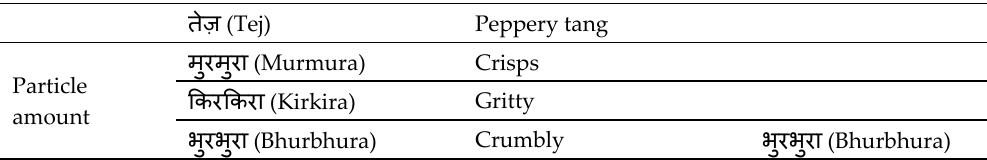
Table 5. Cont. Foods 2019 , 8 , x FOR PEER REVIEW